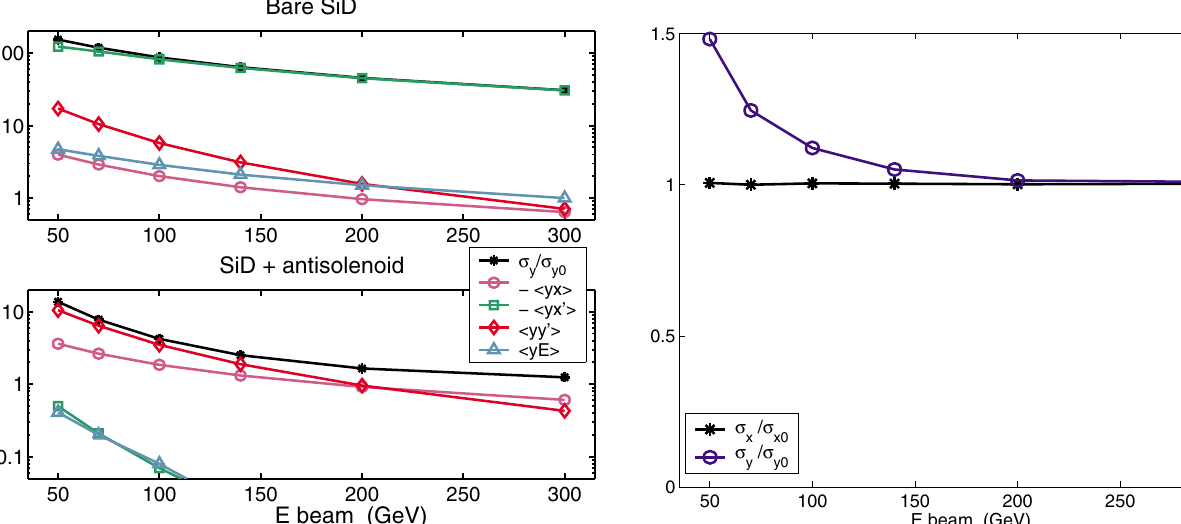
FIG. 19. (Color) Beam size in SiD with the antisolenoid as a function of beam energy. The beam size is corrected only with linear knobs .